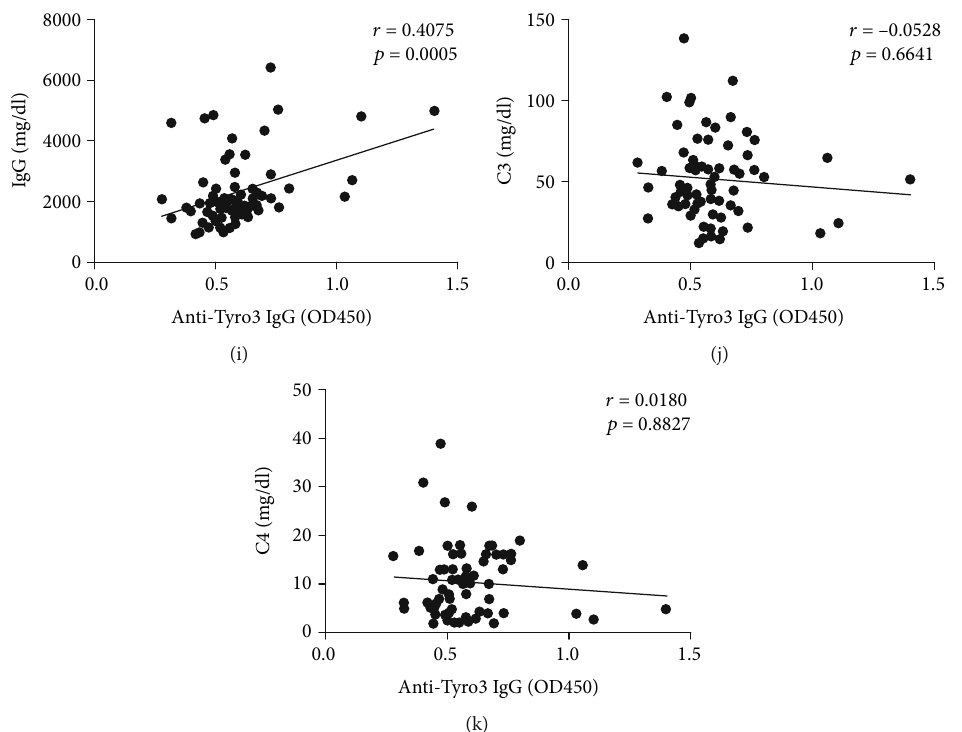
Figure 2: The correlation of anti-Tyro3 IgG levels and clinical manifestations in SLE patients. (a – k) The correlation between anti-Tyro3 IgG levels and SLEDAI score, ESR, Anti-dsDNA Ab, WBC, Hb, PLT, CRP, proteinuria, IgG, C3, and C4 in SLE patients. p < 0 : 05 represents a signi fi cant di ff erence. SLE: systemic lupus erythematosus; HC: healthy control; ESR: erythrocyte sedimentation rate; SLEDAI: SLE disease activity index; anti-dsDNA Ab: anti-double-stranded DNA antibody; WBC: white blood cell; Hb: haemoglobin; PLT: platelet; CRP: C- reactive protein; IgG: immunoglobulin G; C3: complement 3; C4: complement